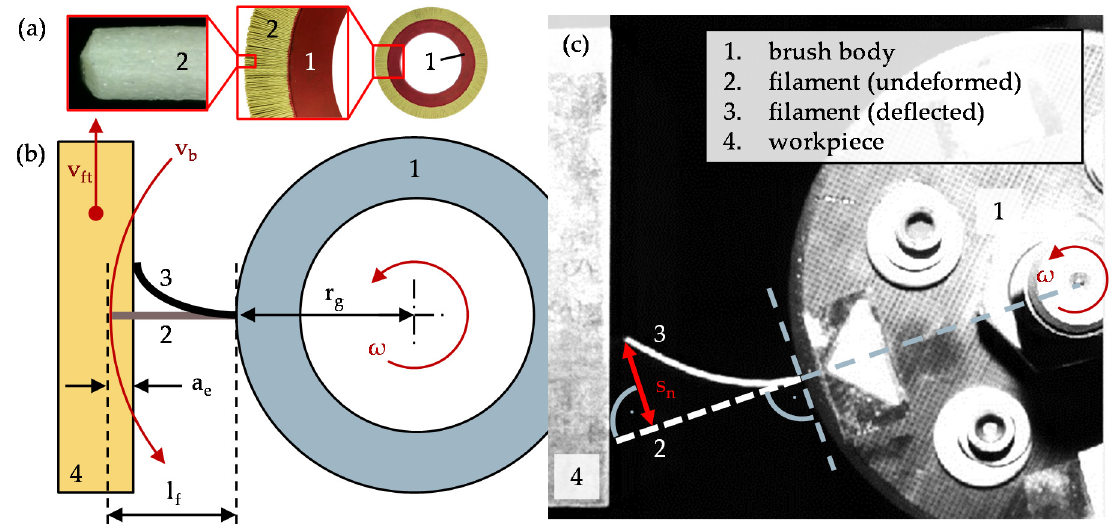
Figure 1. Brushing with bonded abrasives; ( a ) round brush with diamond grains; ( b ) contact proportions during brushing, schematically depicted on the basis of a single abrasive filament; ( c ) technological investigations with a single abrasive filament during workpiece contact, capturing the filament tip deflection s n .